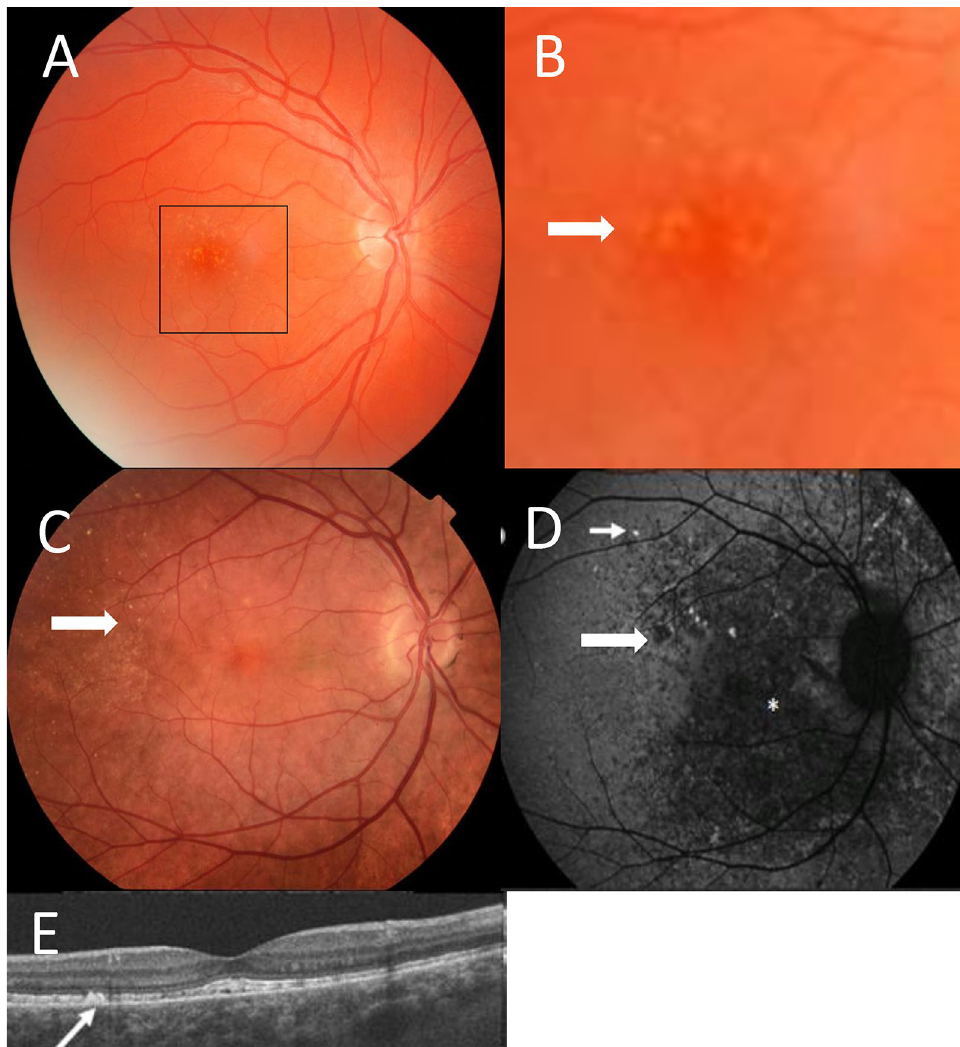
fundus from an individual with ulcerative colitis demonstrating drusen (arrow); ( D ). autofluorescence view of the fundus in ( C ). demonstrating hyperfluorescent drusen (arrow), hypofluorescent drusen (arrow) and areas of hypofluorescence (asterisks); and ( E ). focal drusen in ( C ) and ( D ) resulting in irregularity of outer retinal layers on optical coherence tomography (OCT, Heidelberg Engineering)